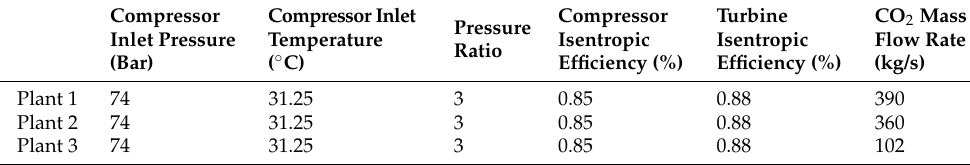
Table 5. Proprieties of sc-CO 2 BC.